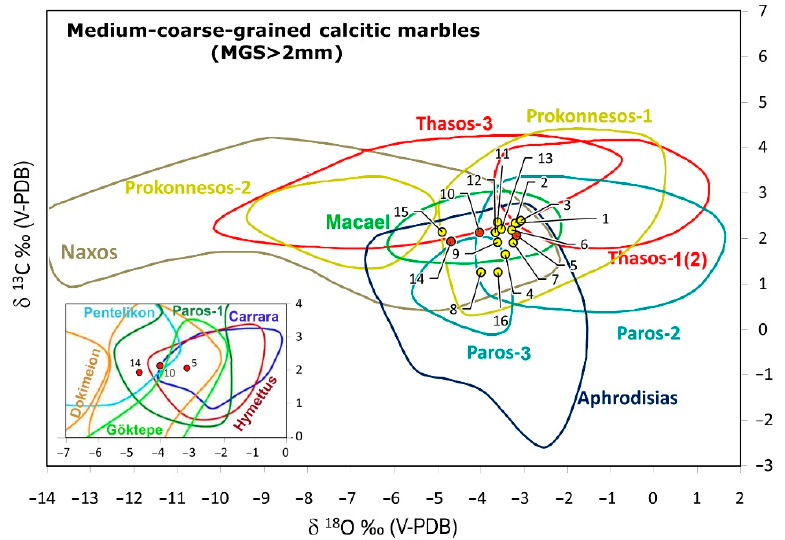
Figure 3. Isotopic results from the analyzed samples plot with the isotopic reference isotopic fields for medium/coarse-grained classical marbles from [19]. Macael reference field from [20] is also included. In an inset plot, samples with MGS < 2 (red dots) are also represented with respect to the fine-grained isotopic diagram proposed by [19].